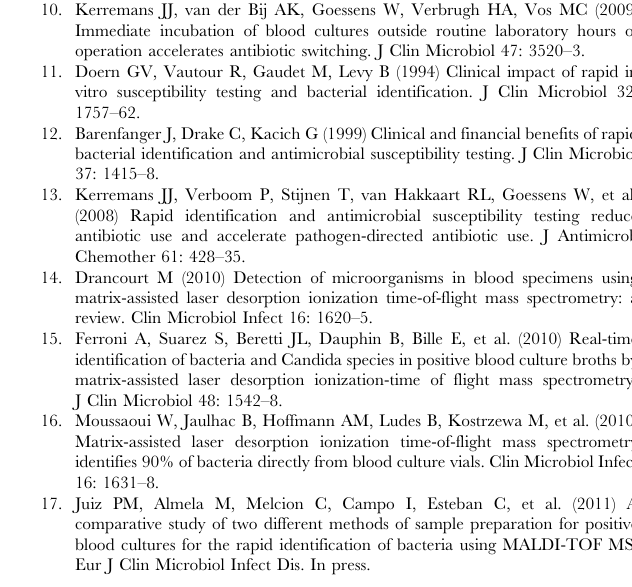
Table S2 Conventional and direct MALDI-TOF MS identification of isolated pathogens from 77 monobac- terial samples. Table S3 Antimicrobial therapy considered inappropri-